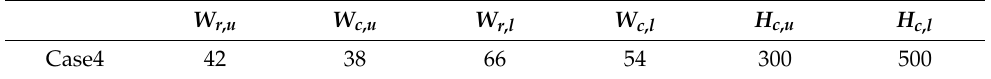
Table 8. The optimized geometry parameters of the proposed double-layer microchannel heat sink.